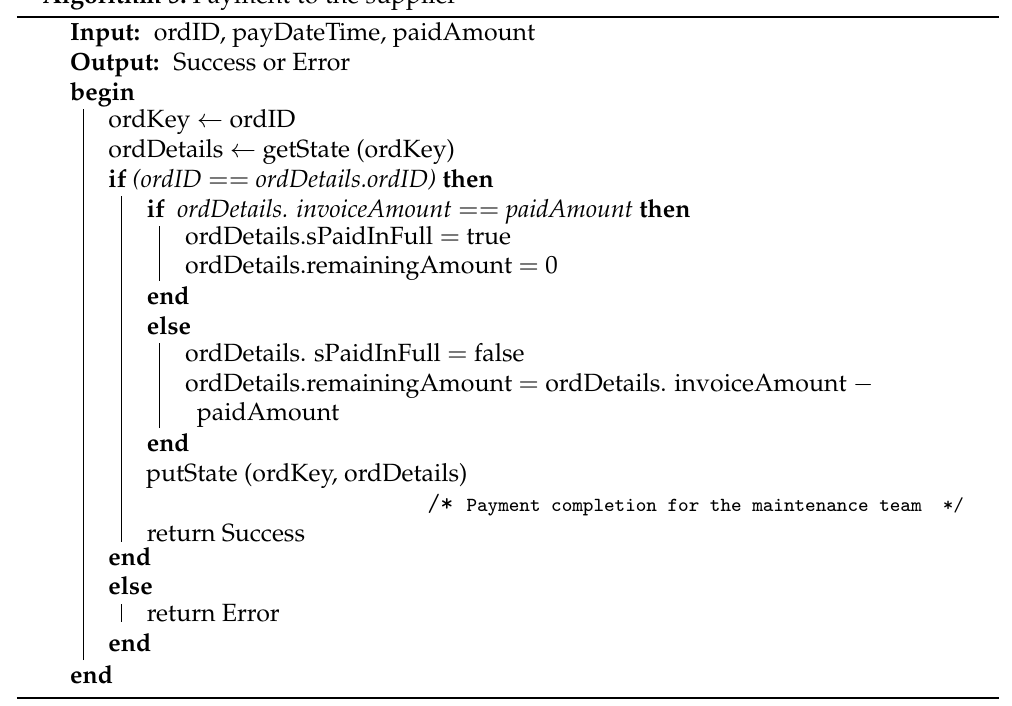
Algorithm 5: Payment to the supplier